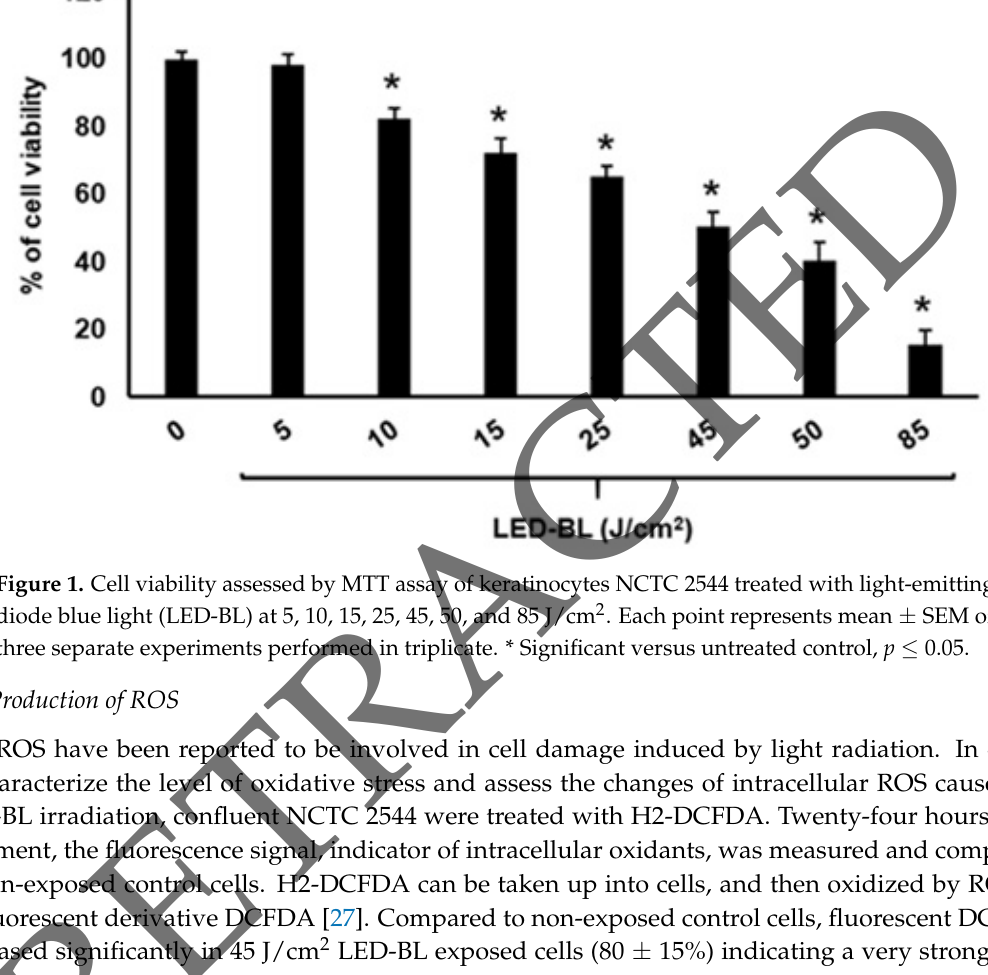
Figure 1. Cell viability assessed by MTT assay of keratinocytes NCTC 2544 treated with light-emitting diode blue light (LED-BL) at 5, 10, 15, 25, 45, 50, and 85 J/cm 2 . Each point represents mean ± SEM of three separate experiments performed in triplicate. * Significant versus untreated control, p ≤ 0.05.